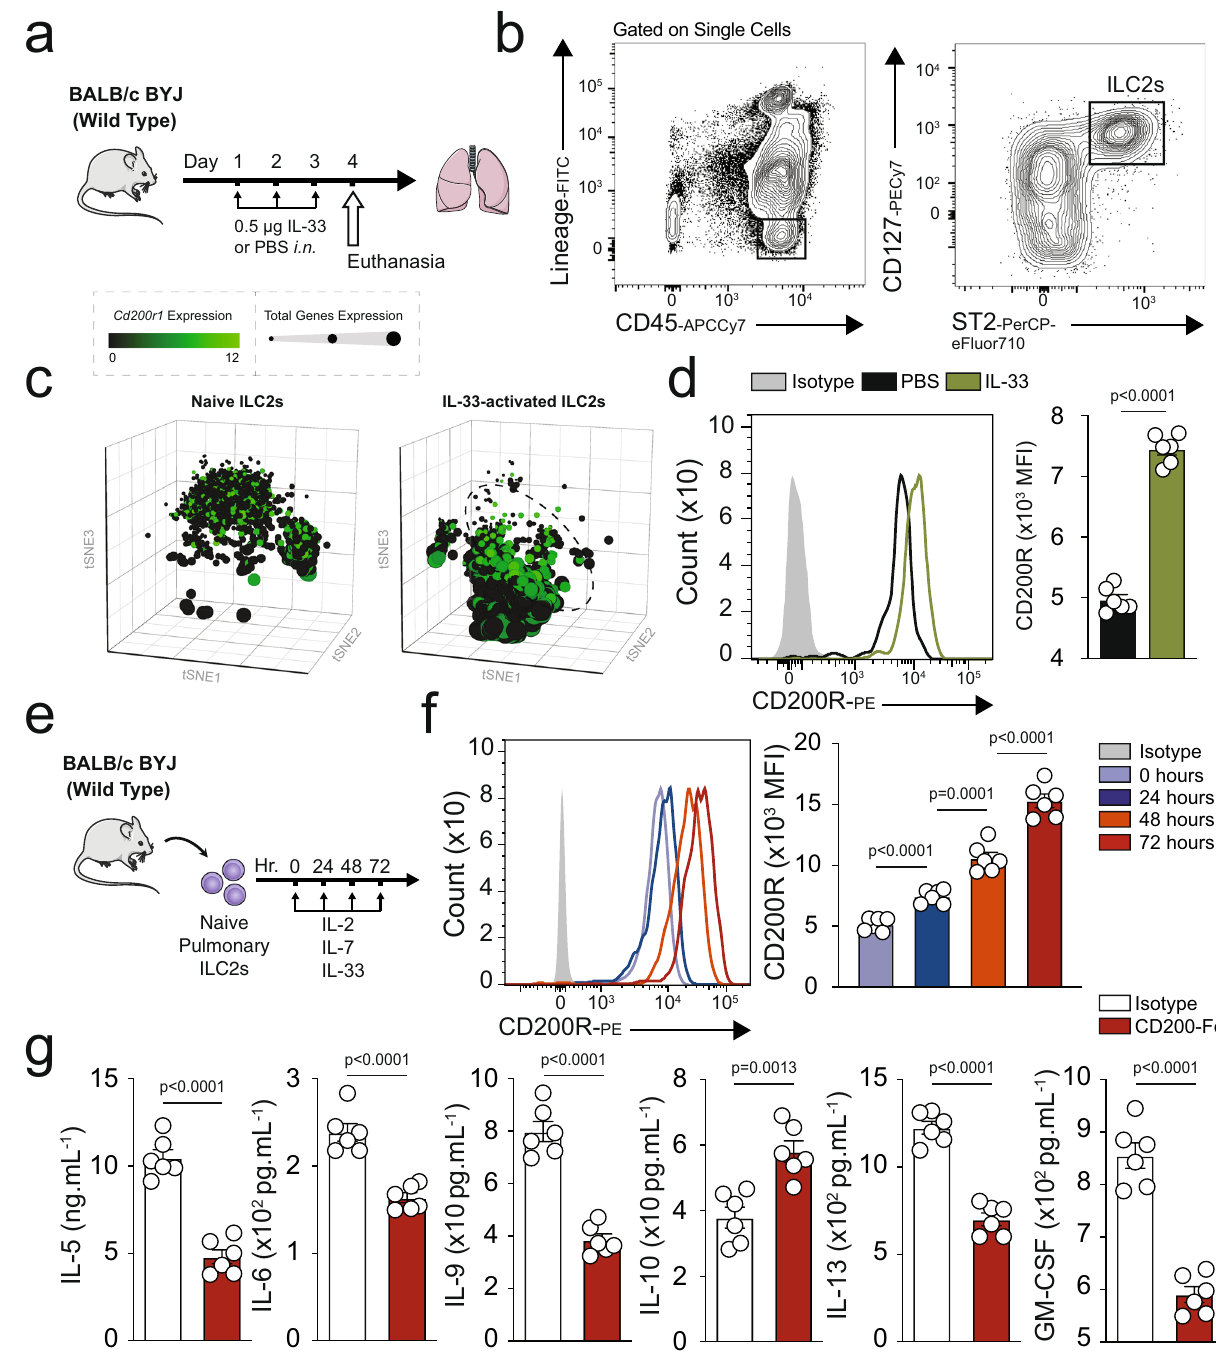
Fig. 1 Mouse ILC2s express CD200R and this expression is inducible by IL-33. a A cohort of WT mice were challenged with recombinant mouse (rm) IL- 33 (0.5 µ g) or PBS intranasally (i.n.) on days 1, 2, and 3. The mice were euthanized on day 4 and the lung was isolated, as shown in the timeline. b The gating strategy of ILC2s identi fi ed as Lin − CD45 + CD127 + ST2 + cells. c , d mRNA (tSNE plot of 4474 naïve and 3390 activated ILC2s; dot size is indicative of the total gene expression level in each cell; dashed line encloses cells with highest CD200R expression) and protein expression levels of CD200R in both naïve and IL-33-activated ILC2s in the lungs. Corresponding quantitation of CD200R expression shown as MFI + / − SEM, n = 6 mice. e Naïve pulmonary ILC2s were sorted and subsequently cultured with rmIL-2 and rmIL-7 and rmIL-33 for 24, 48, and 72 h. f Freshly isolated ILC2s at 0 h and ex vivo activated ILC2s were analyzed by fl ow cytometry as indicated in the scheme and the kinetics of CD200R induction by rmIL-33 is shown. g Freshly sorted naïve and activated pulmonary ILC2s were cultured in the presence of rmIL-2 and rmIL-7 stimulated with CD200-Fc (10 µ g/mL) or isotype control for 48 h. The levels of IL-5, IL-6, IL-9, IL-10, IL-13, and GM-CSF were measured by Luminex on the culture supernatants, n = 6 mice. Statistical analysis, two-tailed student ’ s t -test or one-way ANOVA followed by Tukey post-hoc tests; Data are shown as means ± SEMs and are representative of three individual experiments. Mouse and lung images are sourced through an open access license from Servier Medical